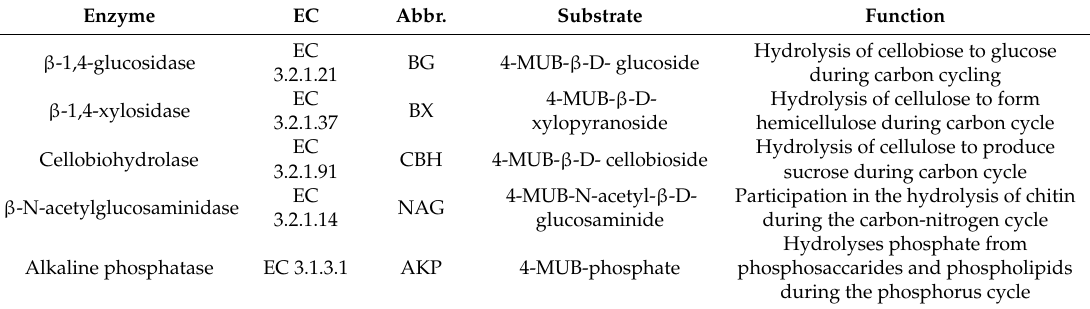
Table 1. Abbreviations, substrates, and functions of soil extracellular